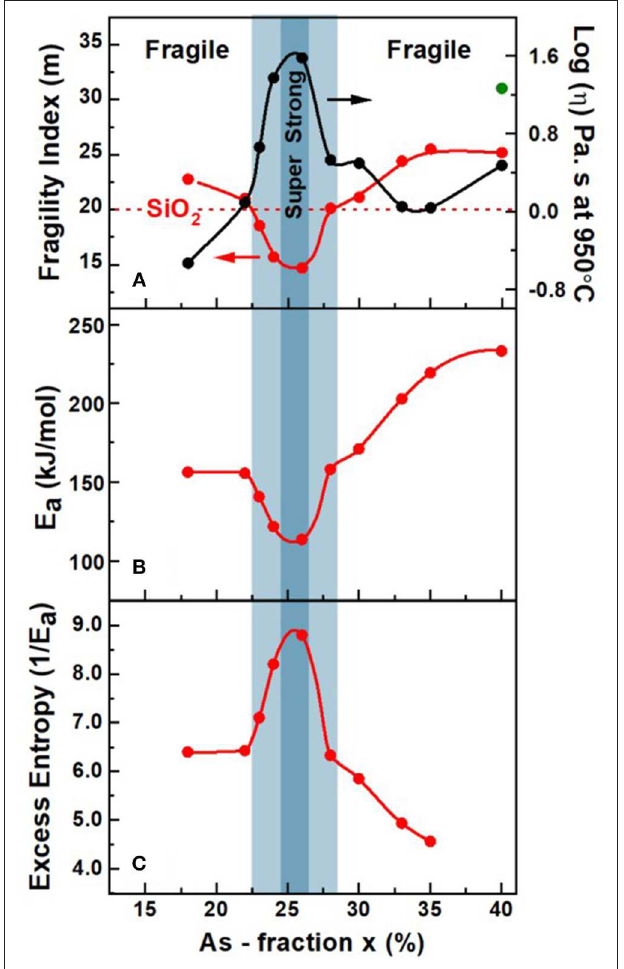
FIGURE 12 | (A) Observed variation in fragility index m(x), (B) activation energy of enthalpy relaxation time, E a (x), and (C) the variation in 1/E a with x in As x S 100 − x melts obtained using mDSC. Also included in (A) is the projected variation (•) of melt viscosity ( η ) based on the presently measured m(x) and the MYEGA formalism (Mauro et al., 2009). In (A) the observed Gaussian—like minimum in m(x) centered around the reversibility window (shaded light blue), with m < 20 in the window and acquiring values of m > 20 outside the window, serves to define the fragility window . The super—strong character of melts near x = 25.0% acquiring an m = 15.0, is illustrated with a darker blue color. The green color data for m(x) of 31 at x = 40% is from Dilatometric measurements of Málek (1997).